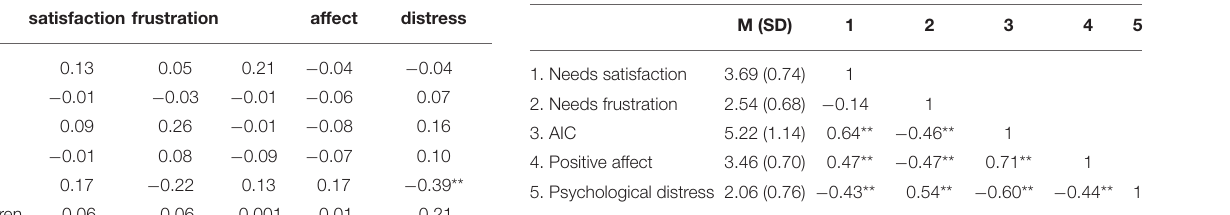
TABLE 3 | Descriptive statistics and correlations between study